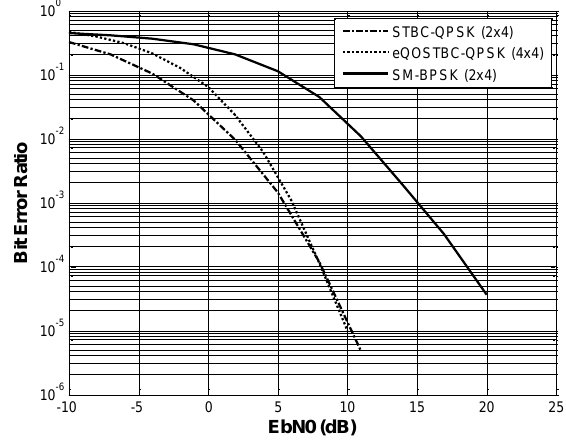
Figure 8: Comparison of two bits transmissions using SM, STBC and QOSTBC